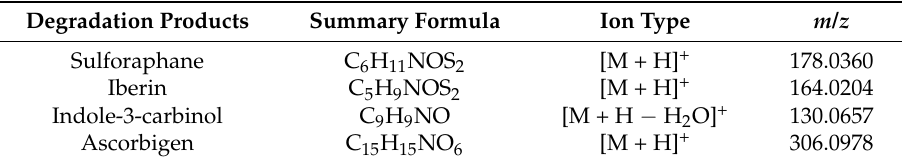
Table 5. Degradation products of GSLs identified in Albatros and Target cv.